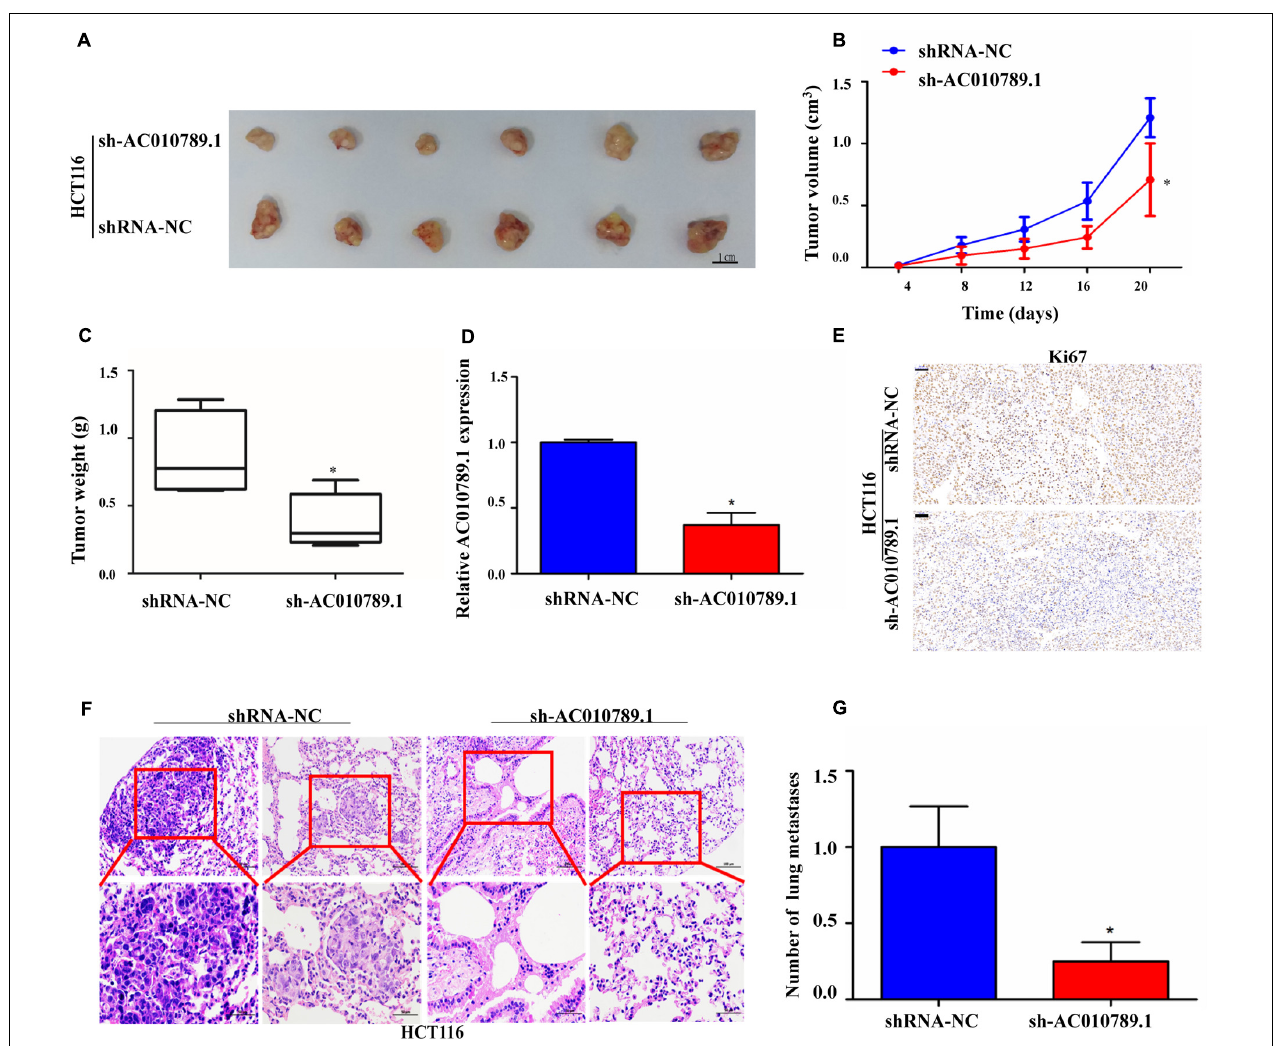
FIGURE 3 | Silencing AC010789.1 inhibits tumor growth and metastasis in vivo. (A) The subcutaneous xenograft tumors of HCT116 cells isolated from nude mice; tumors were photographed from each group ( n = 6), Scale bar: 1 cm. (B) The tumor growth curves of in vivo tumor volumes ( n = 6/group). (C) Tumor weights of each group ( n = 6) were also measured. (D) The qRT-PCR was performed to detect the expression level of AC010789.1 in the tumors ( n = 6/group). (E) Representative images of immunohistochemistry stained for Ki67 using the tumor section, Scale bar: 50 µ m. (F) The microscopic images of lung tissue sections stained by hematoxylin and eosin. (G) The number of metastatic nodules in the lung were counted. Data are presented as mean ± SEM, n = 6 for each group. P -values were determined by two-tailed student’s t -test (* P < 0.05).